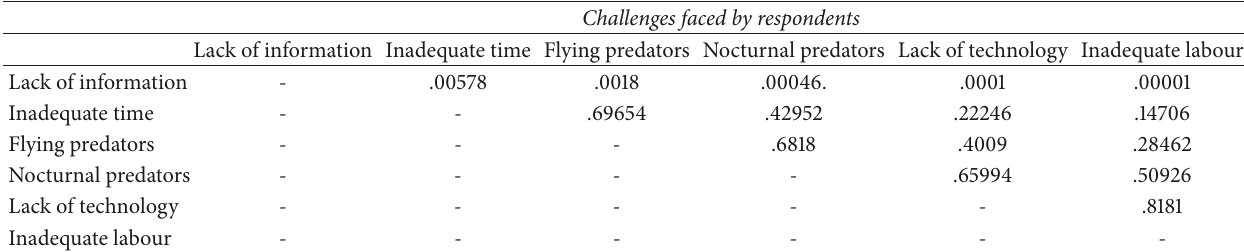
Table 8: P-value matrix for cross tabulation of challenges faced by